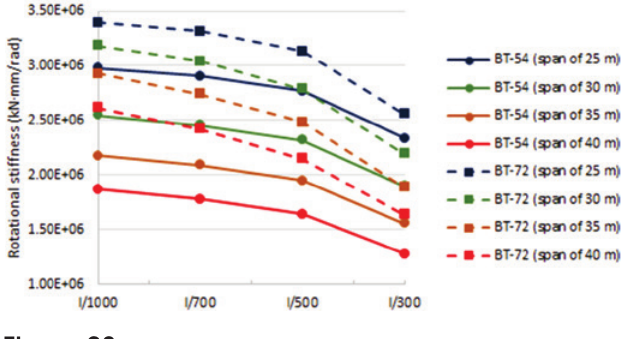
Effective stiffness around X × mid-span eccentricity (limit